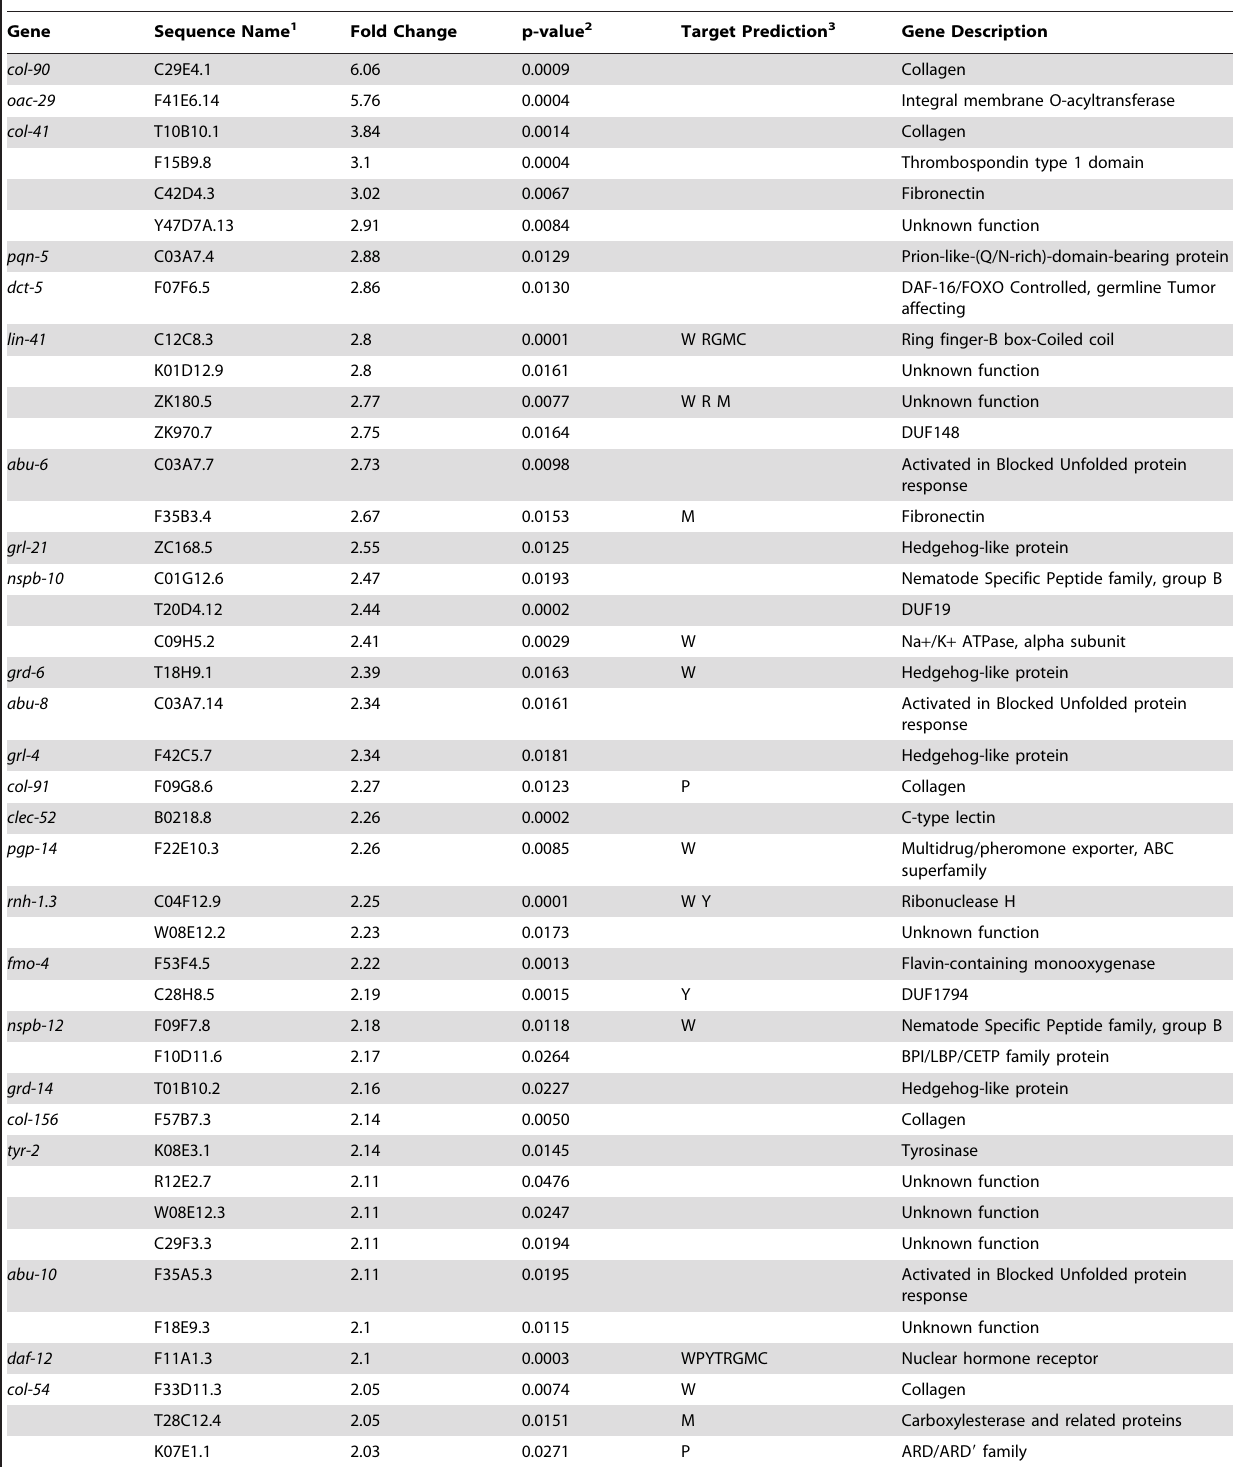
Table 1. Genes up-regulated more than 2-fold in let-7(n2853) compared to wild-type.